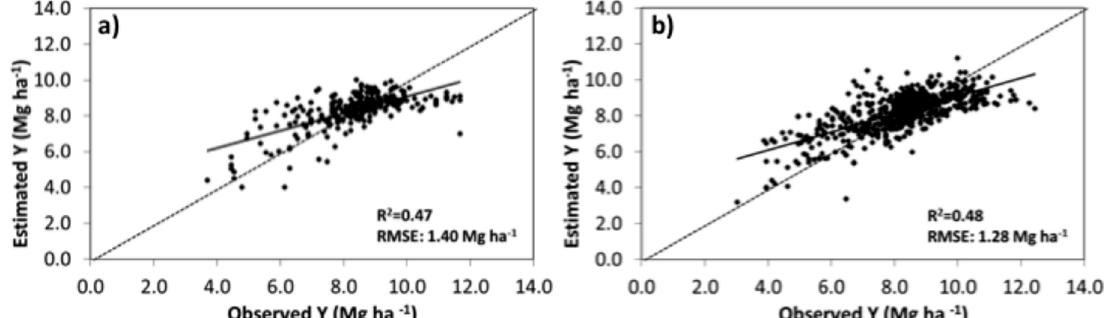
Figure 3. Estimated corn yield versus end-season observed corn yield (yield monitor data), both expressed in absolute terms for the meta-function obtained with: ( a ) ordinary least-squares (OLS) model, including fields F3, F4, F7, and F8; and ( b ) the spatial econometric, SPL, model, including fields F2, F5, F6, F9, F10, F12, F14, F15, F16, F17, F18, F19, F20, and F21. The dashed line portrays the 1:1 line for the estimated–observed yield relationship. RMSE = root mean square error.